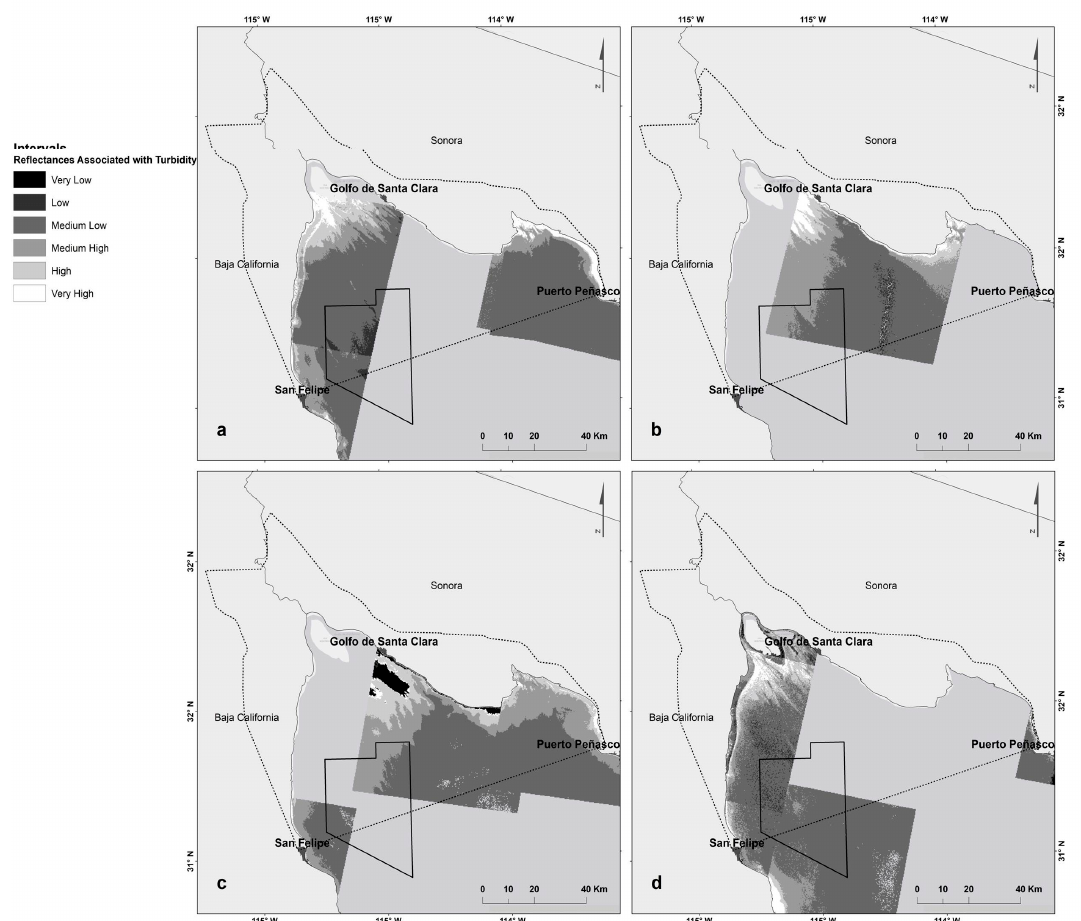
Figure 4. UGC maps of turbidity for the year 2012 in ( a ) cold season, spring tide in flow; ( b ) cold season, neap tide in flow; ( c ) cold season, neap tide in ebb flow and ( d ) warm season, spring tide in flow. The Biosphere Reserve area and the Vaquita marina refuge polygons are